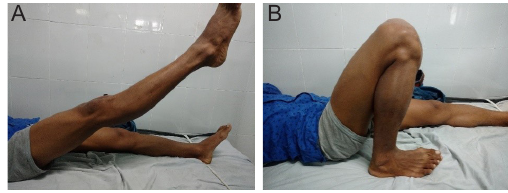
Figure 3. (A) Full extension of knee joint at final follow up. (B) Complete flexion of knee joint at final follow up.